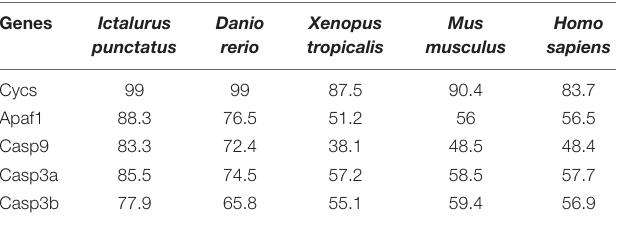
TABLE 2 | Amino acid sequence identity of five apoptosis related genes between P. fulvidraco and other species (%). Genes